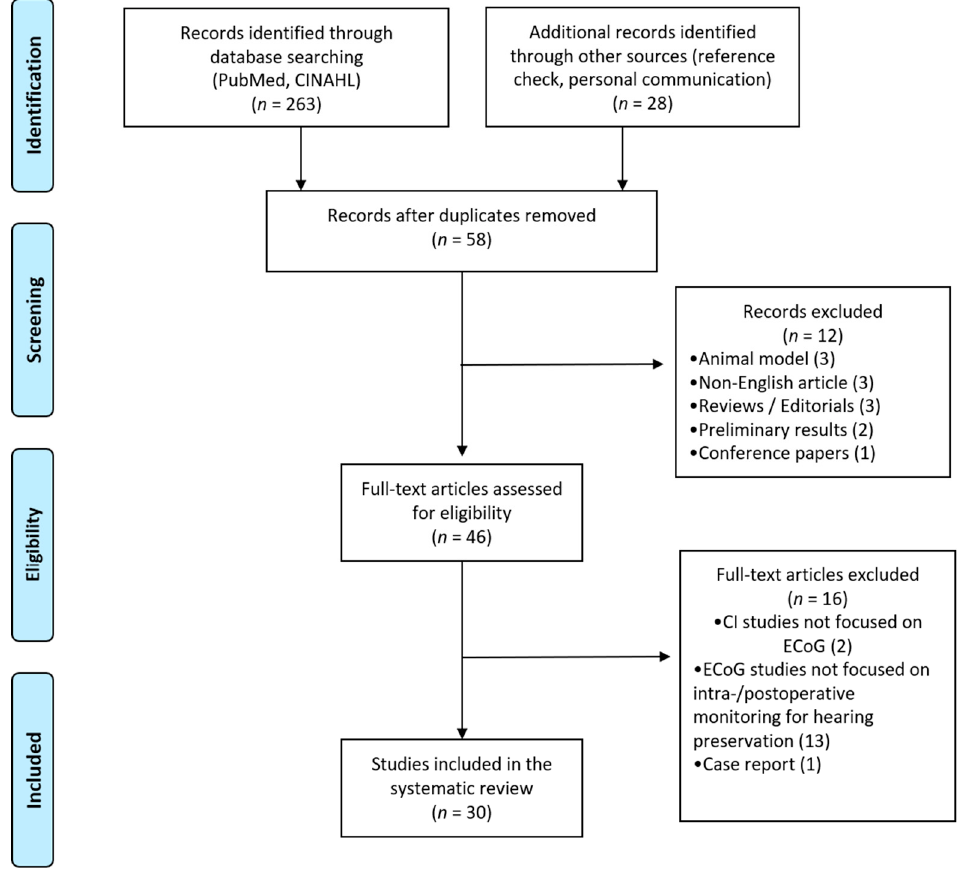
Figure 1. PRISMA (Preferred Reporting Items for Systematic Reviews and Meta-Analysis) flow diagram for study selection.